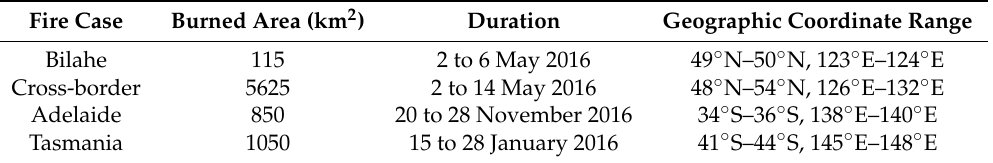
Table 1. Case study fires used for evaluation of the spatiotemporal contextual model (STCM) algorithm.